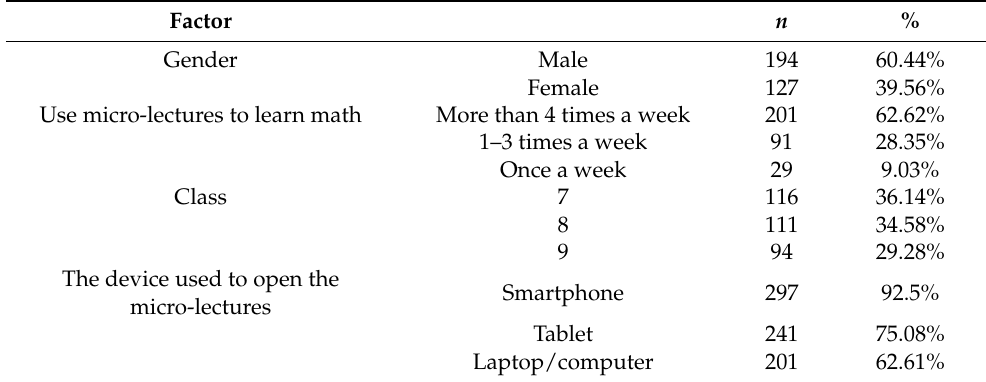
Table 1. The demographic